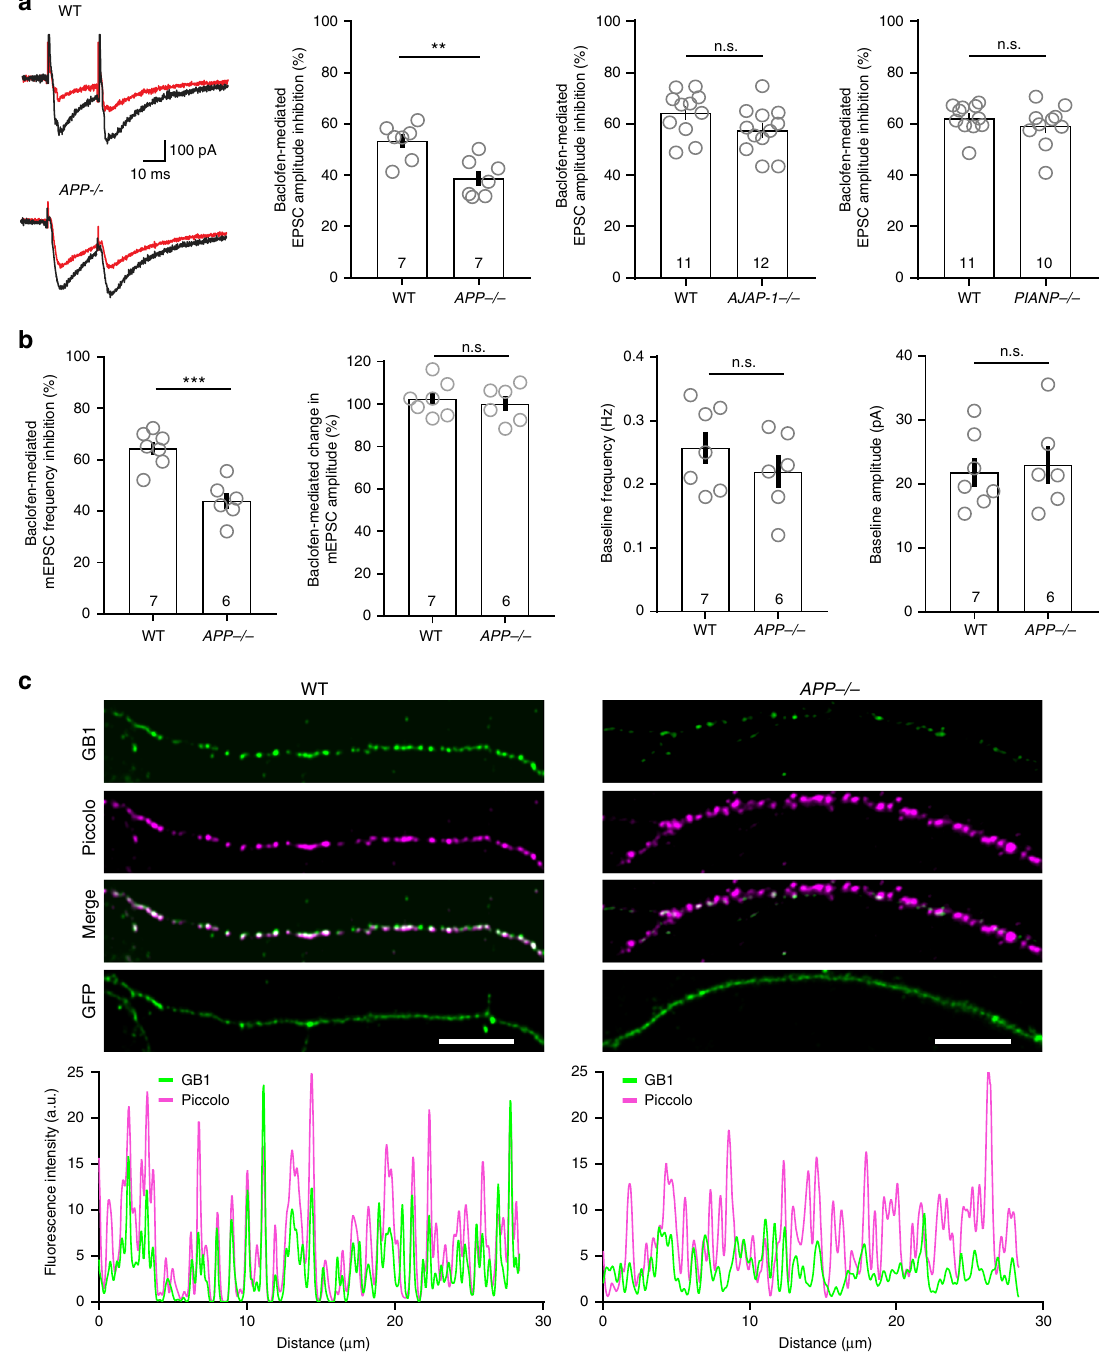
Fig. 3 Reduced axonal GBR expression and presynaptic inhibition in APP − / − mice. a Representative traces of evoked EPSC recordings in CA1 neurons of acute hippocampal slices of APP − / − mice under baseline conditions (control, black) and during 50 μ M baclofen application (red). Bar graphs show reduced baclofen-mediated EPSC amplitude inhibition in APP − / − mice (** P < 0.01, unpaired Student ’ s t -test) while EPSC amplitude inhibition in AJAP-1 − / − , PIANP − / − mice and WT littermate mice did not differ ( P > 0.05). The n number of neurons is indicated. b Bar graphs showing reduced baclofen-mediated inhibition of the mEPSC frequency in CA1 pyramidal neurons of APP − / − mice (*** P < 0.001, unpaired Student ’ s t -test). Baclofen had no effect on the mEPSC amplitude in APP − / − and WT littermate mice. Baseline mEPSC frequency and amplitude were similar in APP − / − and WT littermate mice ( P > 0.05, unpaired t -test). c Top: Immuno fl uorescence of endogenous GB1 protein in axons of hippocampal WT (left) and APP − / − (right) neurons. Neurons expressing GFP were fi xed at DIV10, permeabilized, and immunostained for endogenous GB1 (green) and the presynaptic marker piccolo (magenta). GFP served as a volume marker. Merged images show GB1 and piccolo co-localization. Scale bar 5 μ m. Bottom: Intensity gray value pro fi le graphs of GB1 (green) and piccolo (magenta). Source data are provided as a Source Data fi le. Data are presented as mean ±